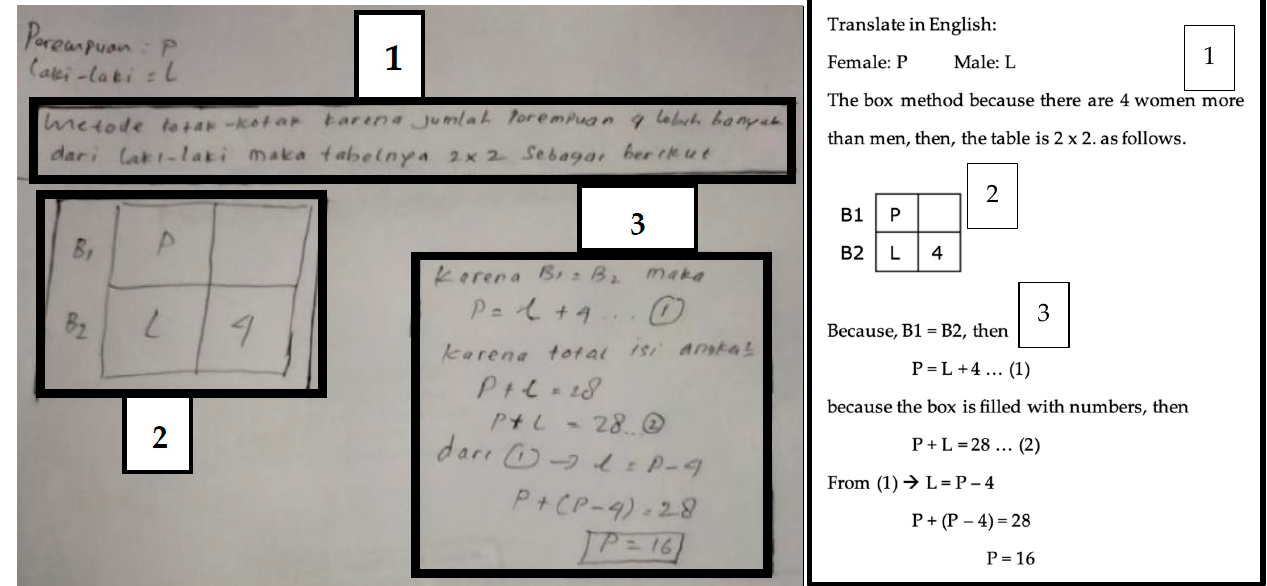
Figure 3. The representation produced by S1.